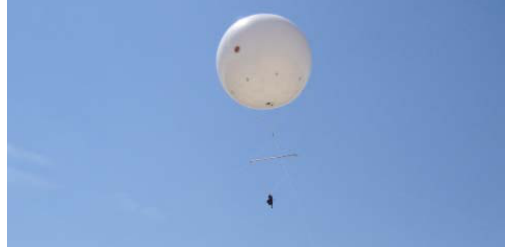
Figure 2. Helium balloon and Picavet platform (NCP case).